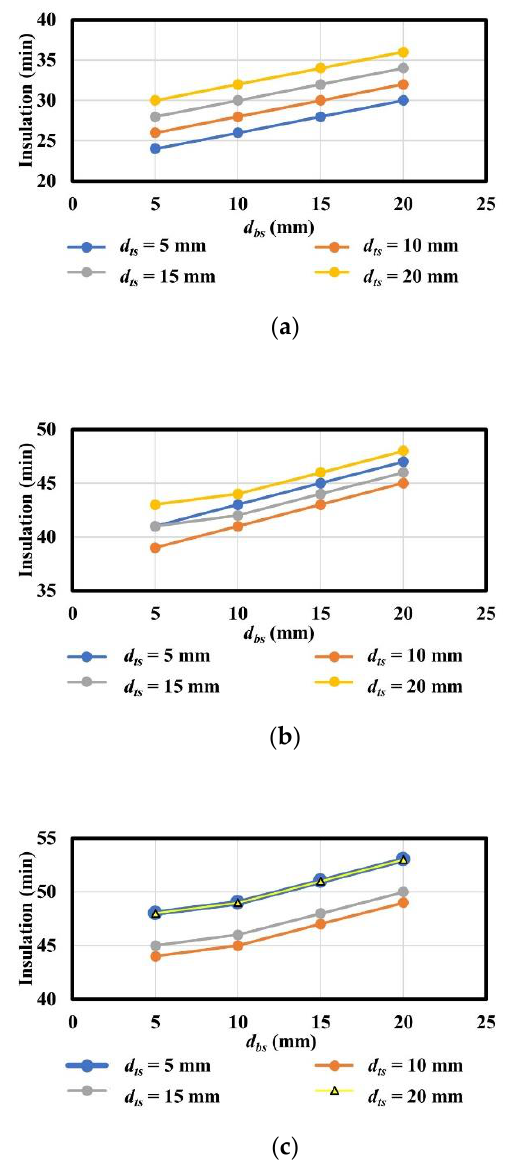
Figure 19. Summary of analysis results Figure 20. Summary of analysis results Figure 20. Summary of analysis results with constant d bs : ( a ) d p = 20 mm with varying d ts ; ( b ) d p = 40 with constant d ts : ( a ) d p = 20 mm with with constant d bs : ( a ) d p = 20 mm with mm with varying d ts ; ( c ) d p = 60 mm with varying d ts varying d bs ; ( b ) d p = 40 mm with varying d bs ; varying d ts ; ( b ) d p = 40 mm with varying d ts ; ( c ) d p = 60 mm with varying d bs . ( c ) d p = 60 mm with varying d ts .